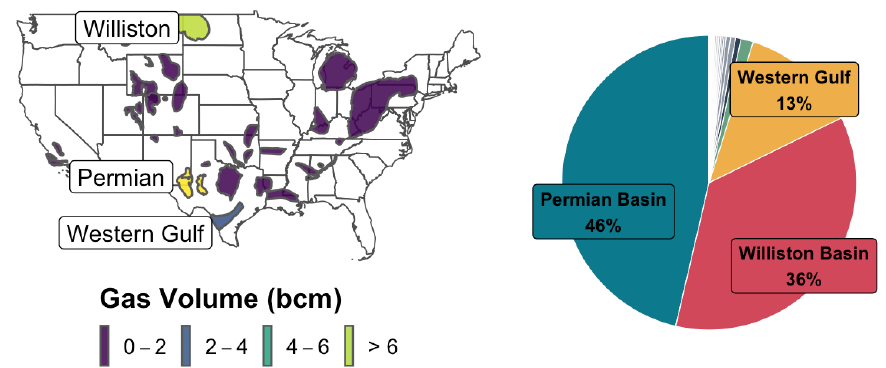
Figure A1. Volume of gas flared per US basin. Over 95% of US flaring in 2019 occurred in Permian, Williston, and Gulf Coast basins. Map on left shows all shale oil and natural gas basins in lower 48 states, with three leading basins labeled.